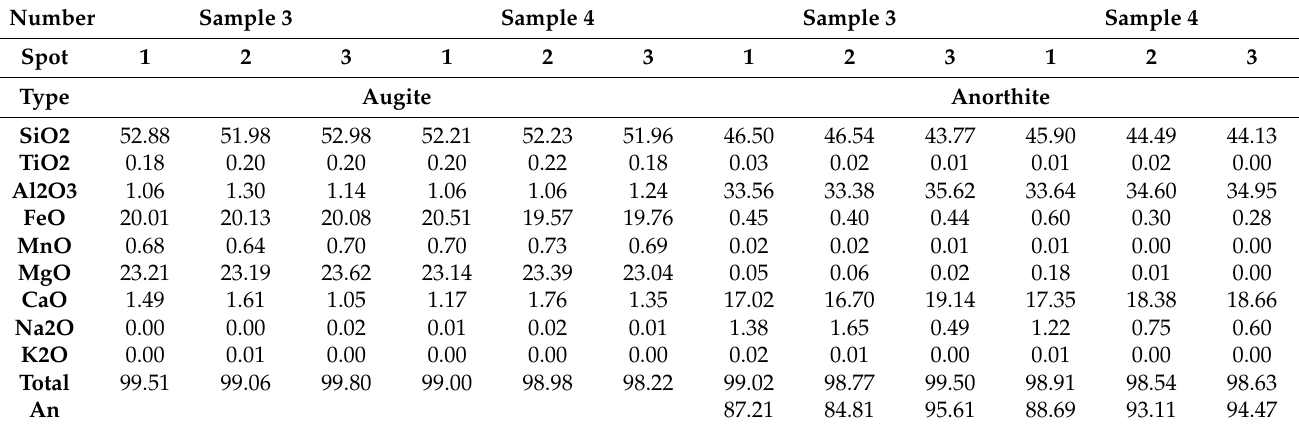
Table 2. Major element compositions of katophorite, amphibole and jadeite in Samples 3 and